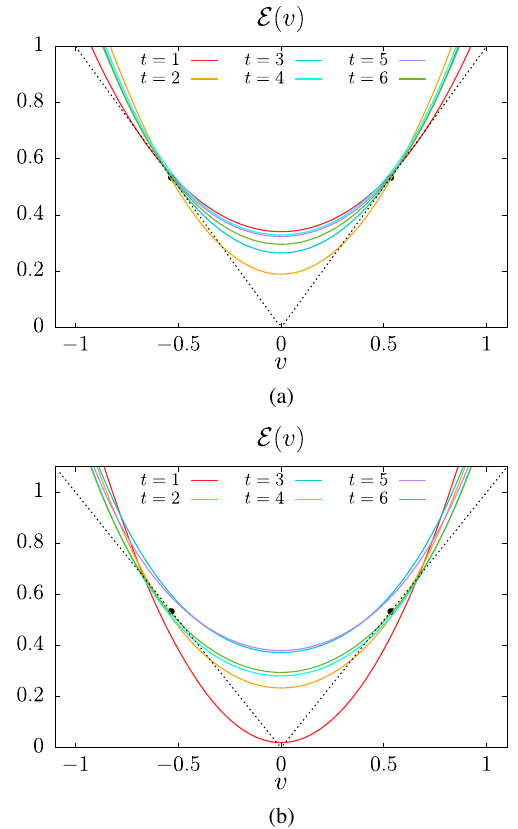
FIG. 16. Numerical calculations of E ð v Þ for Floquet evolution t Þ [Eqs. (104) and (105)] for (a) two-site with the square wave h x ð and (b) one-site schemes.